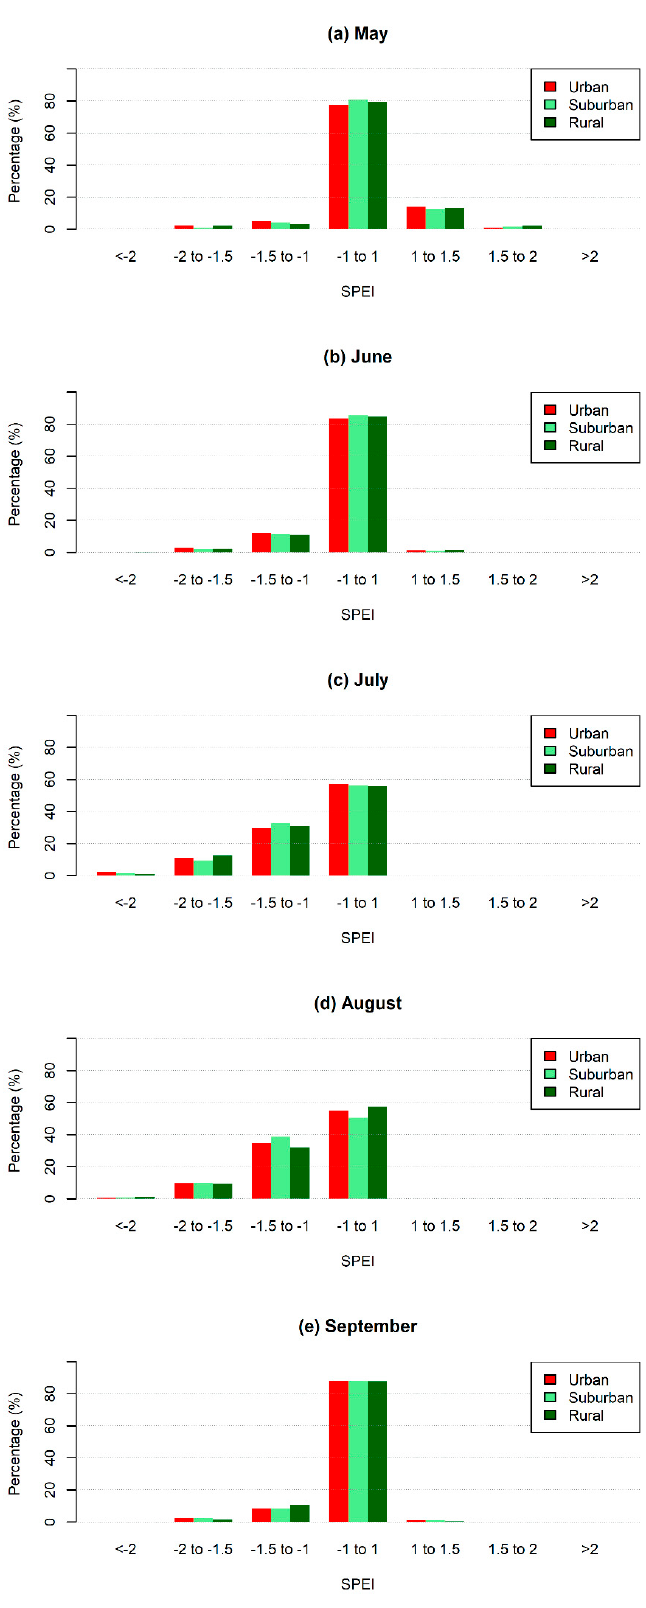
Figure 7. SPEI values for urban, suburban, and rural stations for the months May to September of years